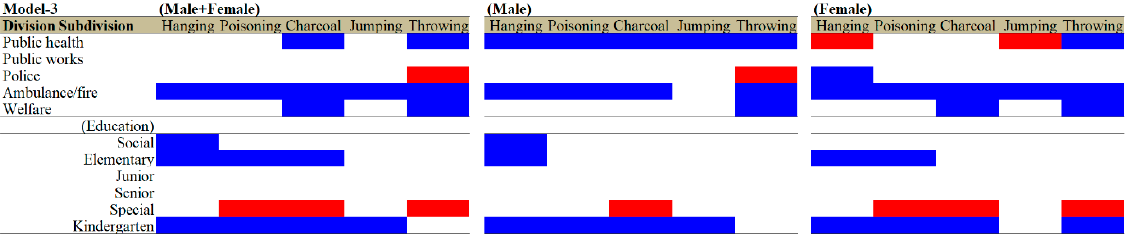
Figure 4. Impacts of expenditure of five major divisions (public health, public works, police, ambulance/fir and welfare) and education subdivisions per capita on suicide mortalities by five major suicide means (hanging, poisoning, charcoal burning, jumping and throwing suicide) of both gender (males plus females), males and females between 2009 and 2018 using fixed- or random-effect analyses of hierarchal linear regression with robust standard error. Blue and red columns, significant factors for decreasing and increasing suicide mortalities.